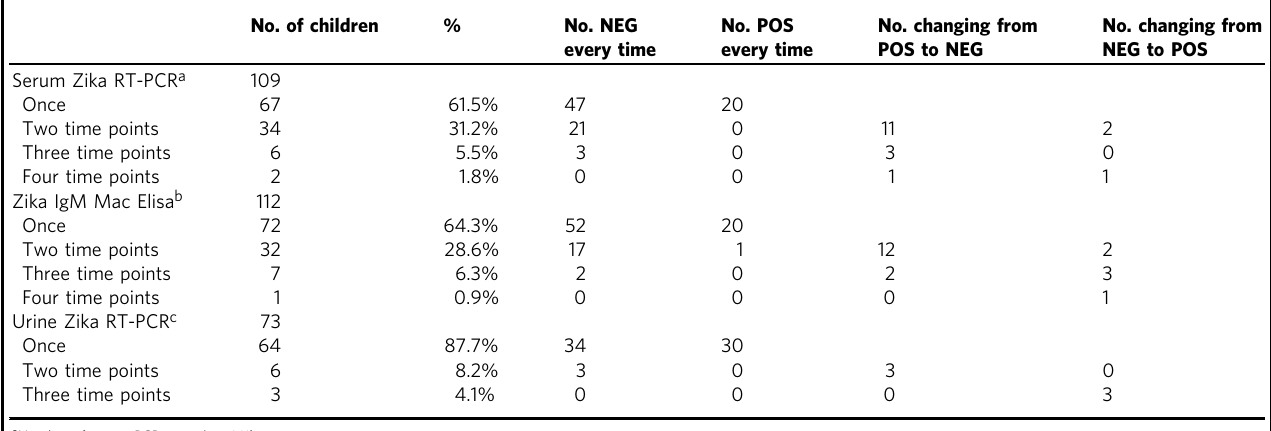
Table 3 Frequency of Zika testing ( n = 407 in 130